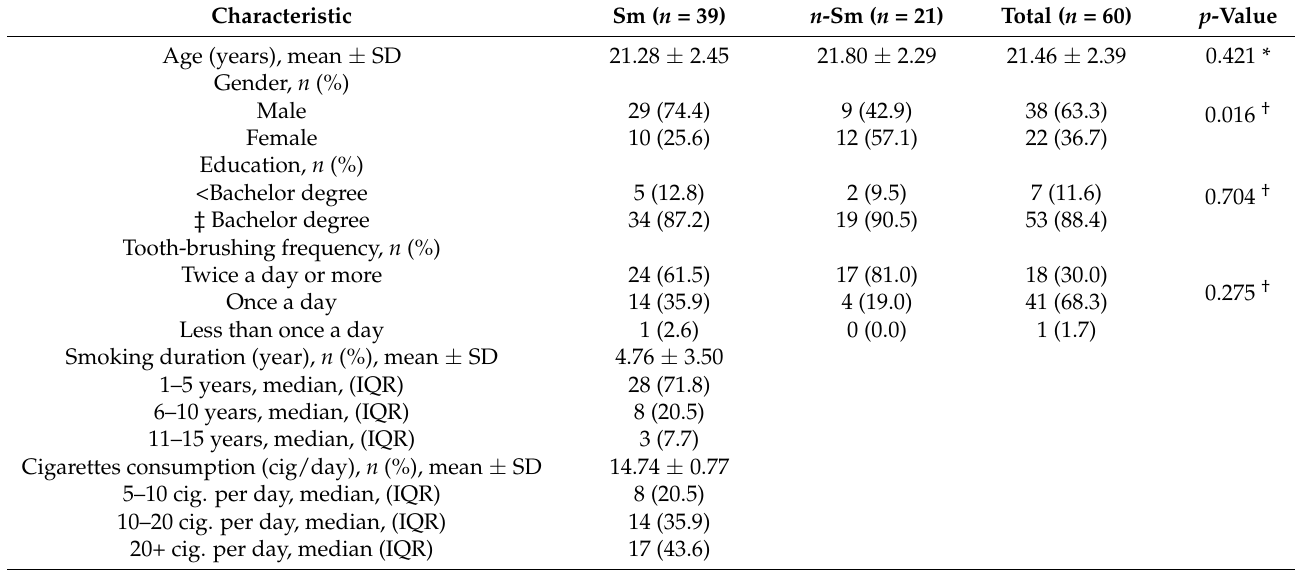
Table 1. Demographic Data for Smokers and Non-Smokers with